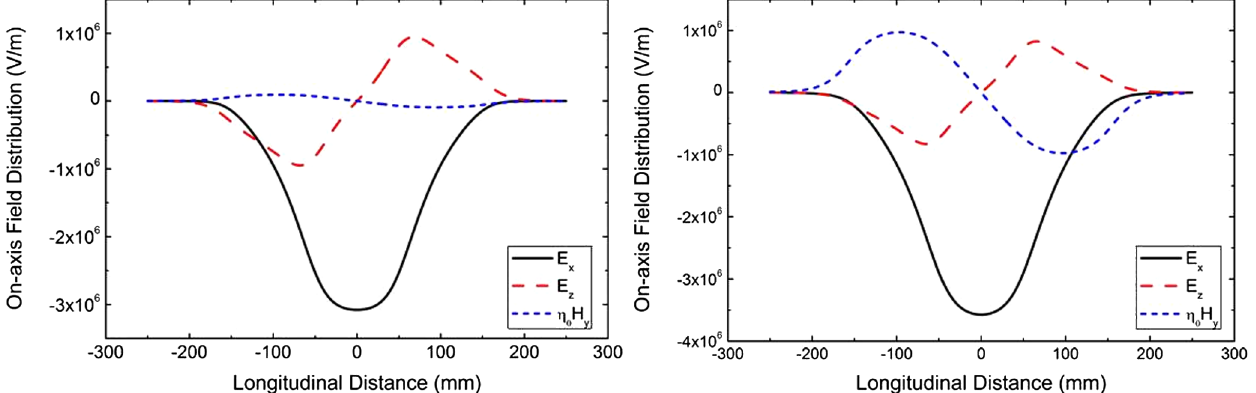
FIG. 3. Field distribution of the fundamental mode (47.63 MHz, left) and the highest mode (428.67 MHz, right) in the five-odd-mode cavity along the beam axis of the deflecting QWR. The magnetic field is multiplied by the free space impedance ( η 0 ¼ 120 π ) to give a fair comparison of the respective contribution of the electric and magnetic field to the transverse kick. All these electromagnetic fields are normalized to 1 J stored